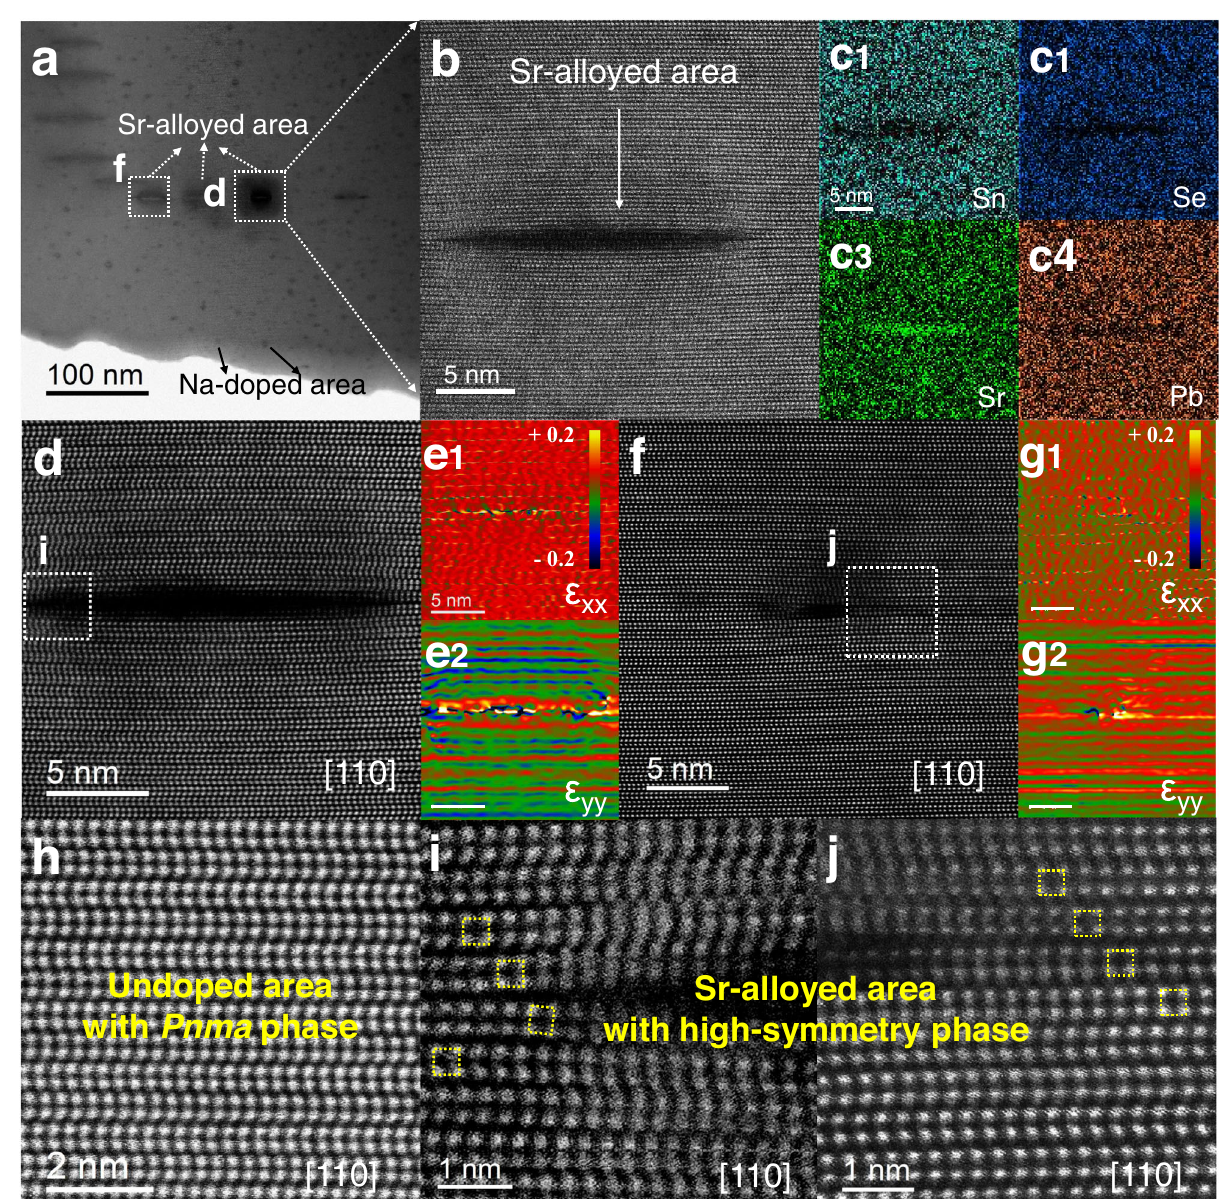
Fig. 5 | Microstructure characterization on the p-type SnSe-9%Pb − 1.2%Sr crys- tal.a TheABF-STEMimageexhibitsthemicrostructuremorphologyofthesample. b The ADF-STEM image indicates the Sr-alloyed area. c1 – c4 Its corresponding elemental analysis. d The HAADF-STEM image of one Sr-alloyed area displays the expanded arrangement of atoms. e1 – e2 The corresponding GPA mappings along